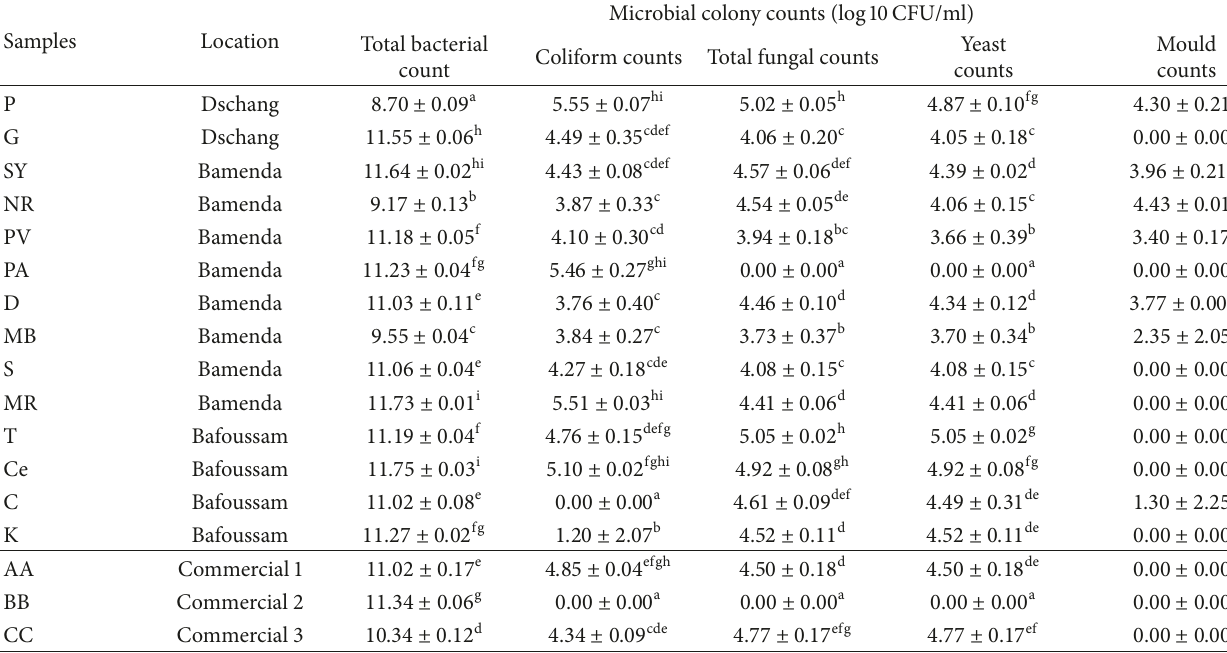
Values are mean ± SD of 3 determinants. Along the columns, values with the same letter (a, b, c, d, e, f, g, and h) are not significantly different ( 𝑝 > 0.05 ).